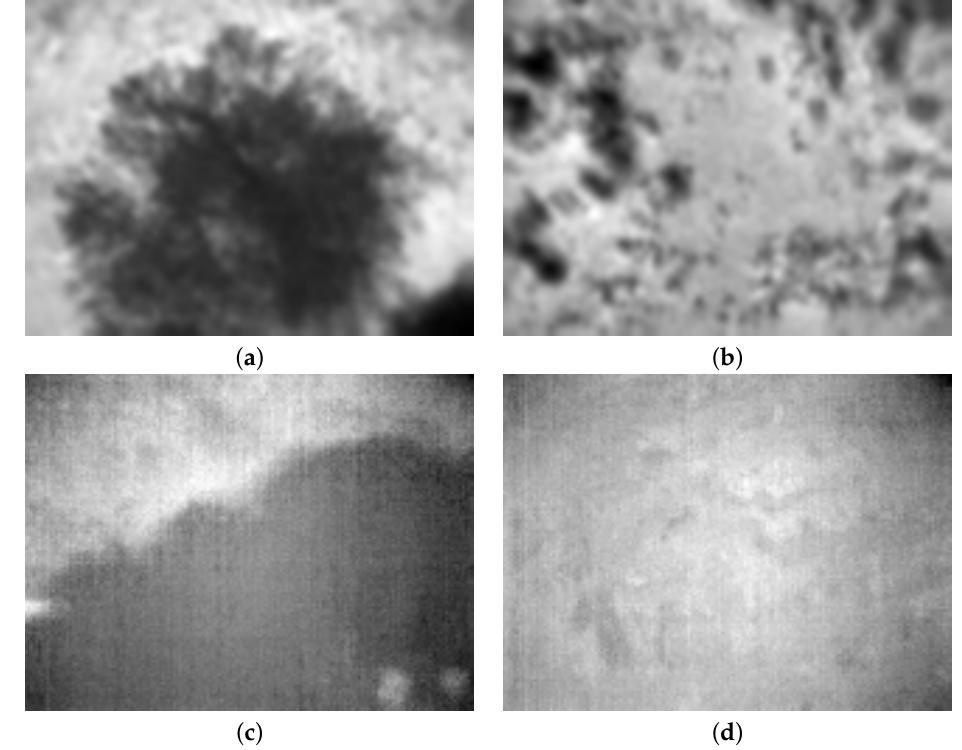
Figure 8. Some of images from dataset 2. Frame (1) and (2) shows the field during high-contrast conditions, and frame (3) and (4) shows thermal images at approximately at the same locations but under low-contrast conditions. ( a ) Frame 1: above a big tree during the high-contrast condition. ( b ) Frame 2: over an empty field during the high-contrast condition. ( c ) Frame 3: over a big tree during the low-contrast condition. ( d ) Frame 4: over an empty field during the low-contrast